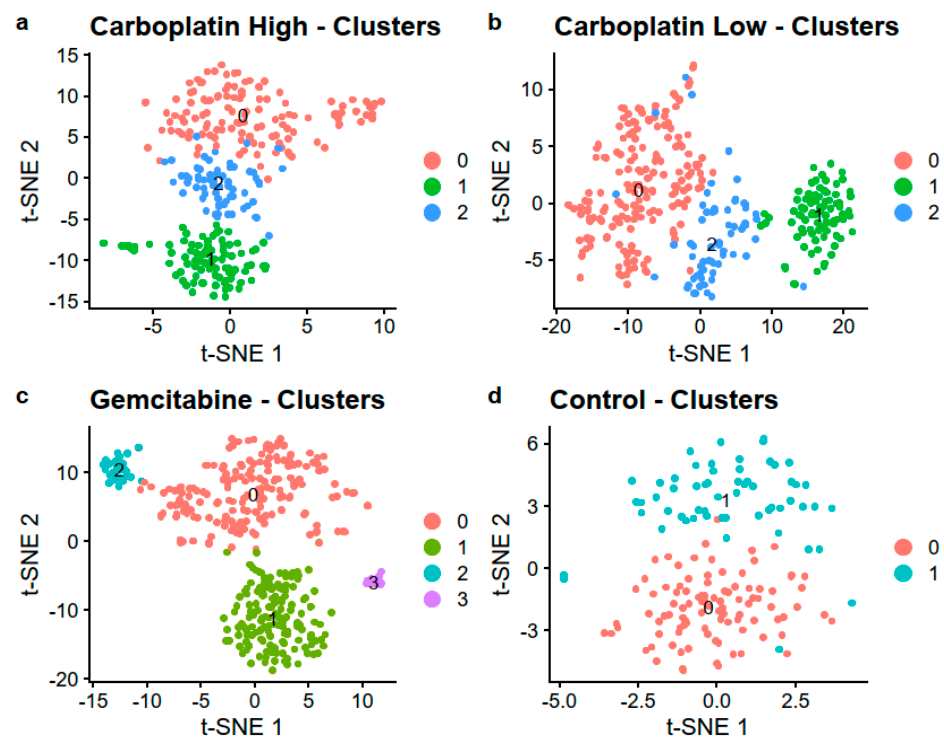
Figure 5. Visualization using t-SNE colored by the identified clusters in the four samples ( a ) Carboplatin High, ( b ) Carboplatin Low, ( c ) Gemcitabine, and ( d ) Table 4. The number of cells in the identified clusters.